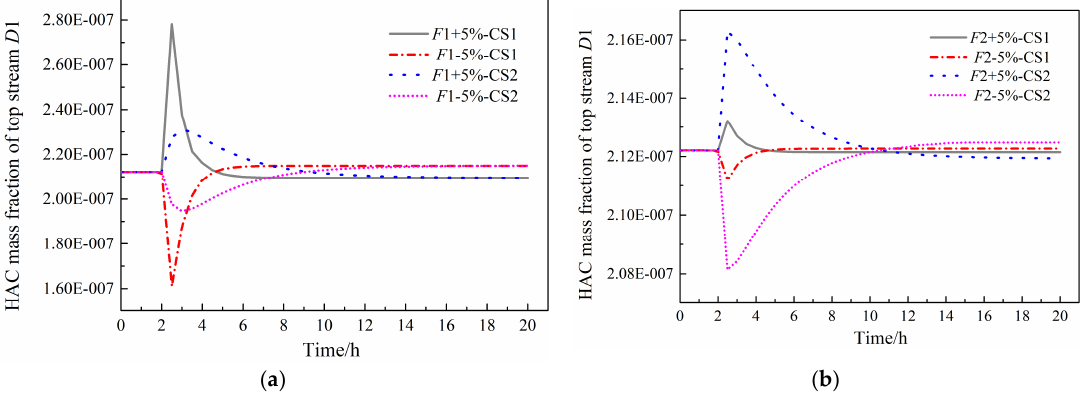
Figure 12. The control responses of the CS1 and CS2 strategies on the mass fraction of the HAc at the top. ( a ) Responses to disturbance in feed F1 and ( b ) responses to disturbance in feed F2.